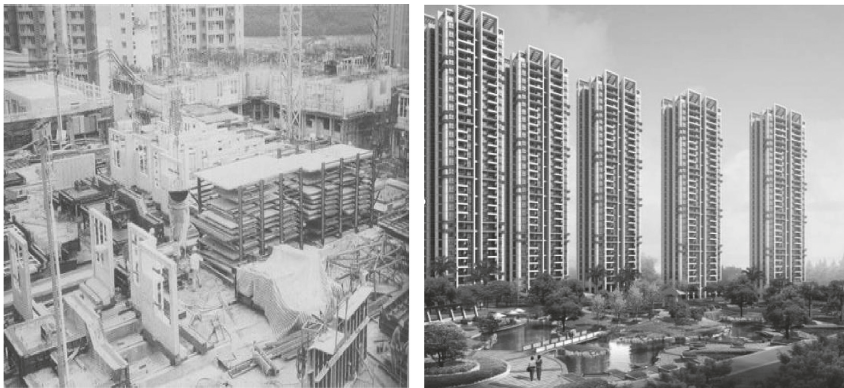
Figure 1: Application of nonlinear matrix ferroelectric composites.